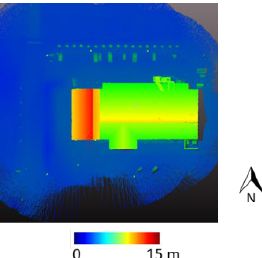
Figure 6. Reconstructed LiDAR point cloud (colored by height) with 31,000,000 points for A-1 dataset.